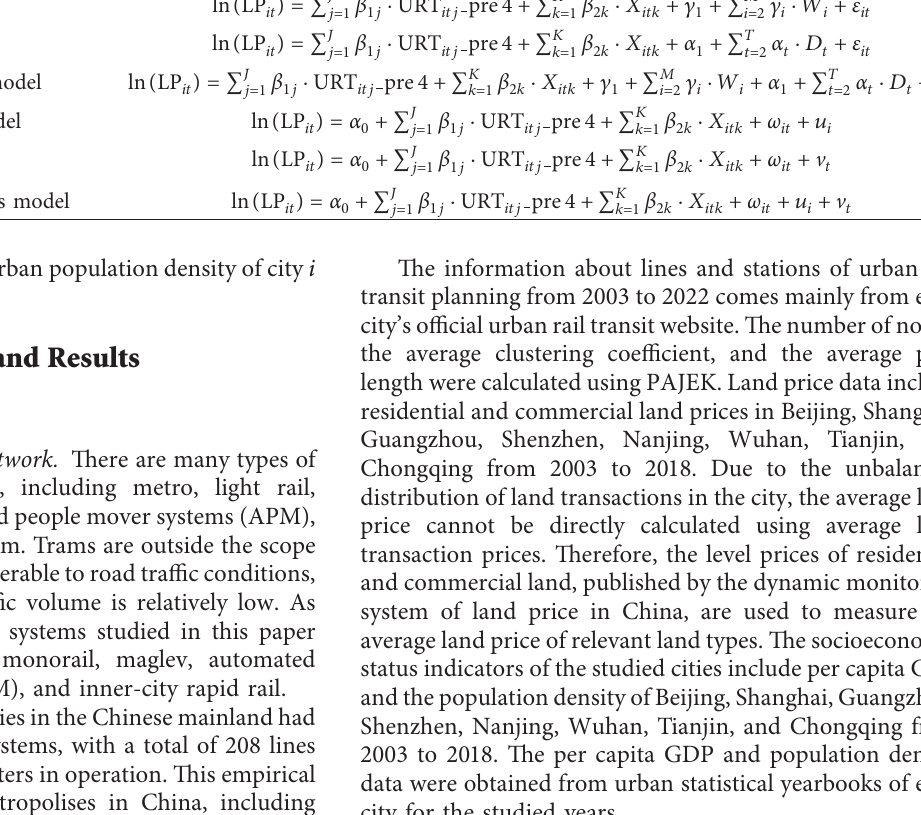
Table 1: Estimation methods for the panel data model to assess the impact of urban rail transit network characteristics on land prices. Estimation method Model equation Pooled model Individual fixed effects model Time fixed effects model Individual-time fixed effects model Individual random effects model Time random effects